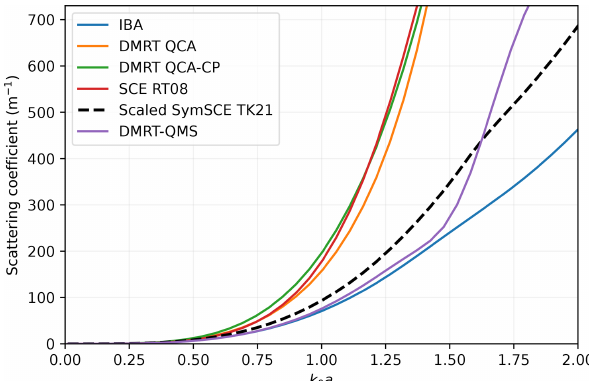
Figure 1. Scattering coefficient as a function of the product of wave number and radius ( k 0 a ) for a variety of electromagnetic the- ories. The microstructure is made of sticky hard spheres with radius 0.5mm, stickiness 0.2 and density 300kgm − 1